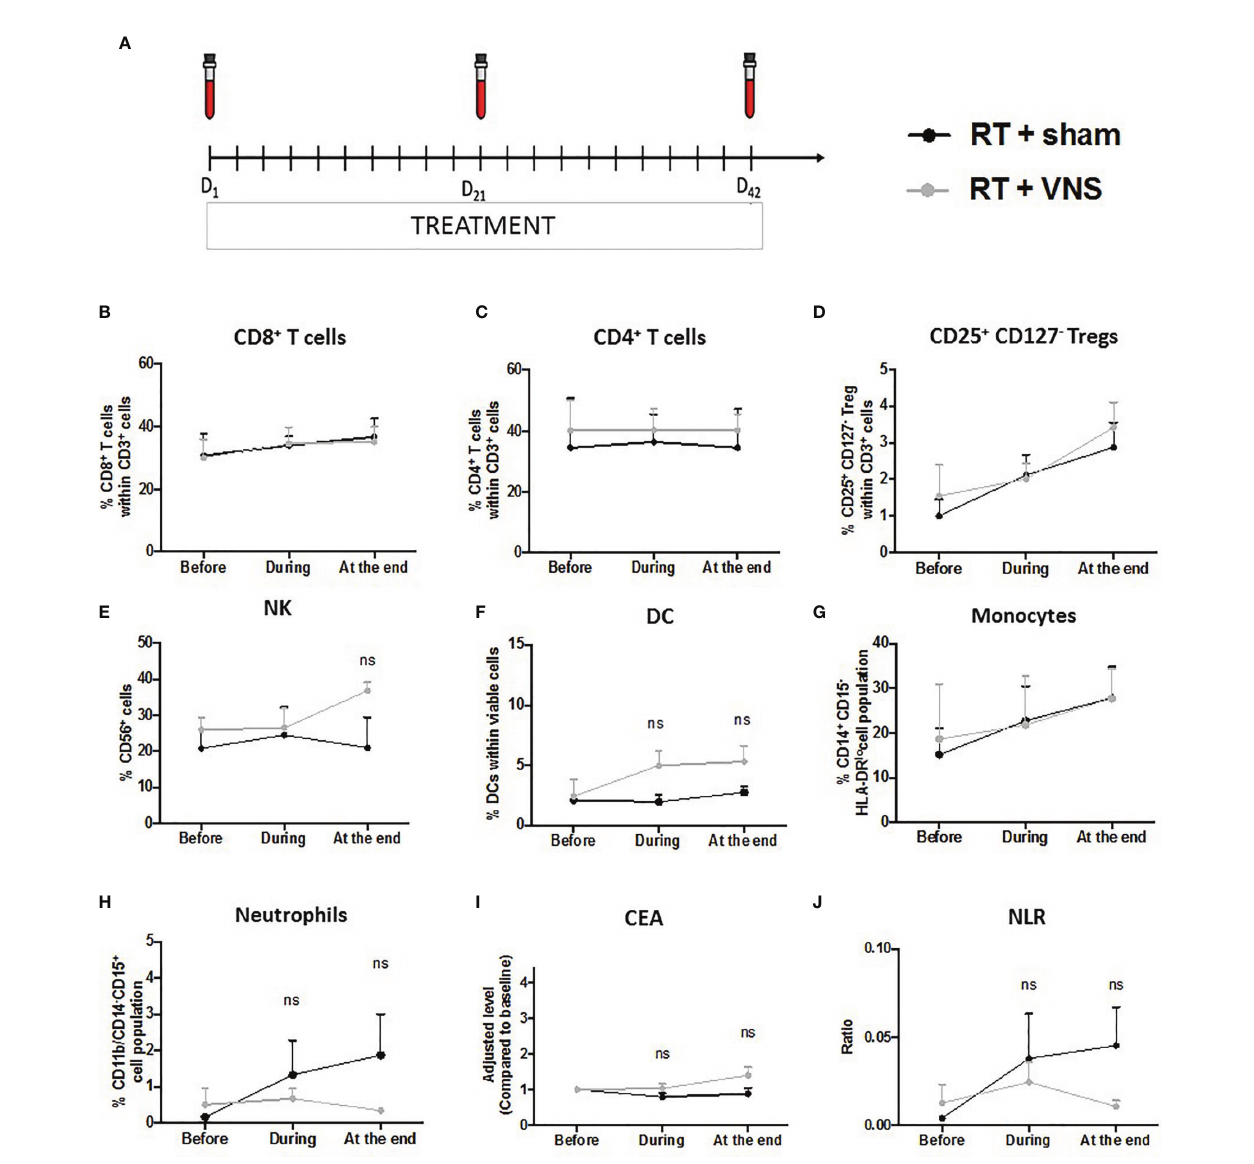
FIGURE 4 | Schematic representation of the clinical trial and impact on lymphoid and myeloid cell populations in NSCLC patients. (A) Subjects ’ visit schedule. Bloods were drawn before the fi rst VNS treatment was performed (baseline), after 3 weeks of ccRTCT (D 21 ) and at the end of ccRTCT (D 42 ). Flow cytometric analysis comparing the levels of (B) CD8 + T cells, (C) CD4 + T cells, (D) CD25 + CD127 - Tregs, (E) NK cells, (F) DC, (G) CD14 + CD15 − HLA-DR lo/ – monocytes and (H) CD11b + CD14 − CD15 + neutrophils in both cohorts. Adjusted serum levels (normalized against baseline levels) of the prognostic markers (I) CEA and (J) NLR. ns, non signi fi